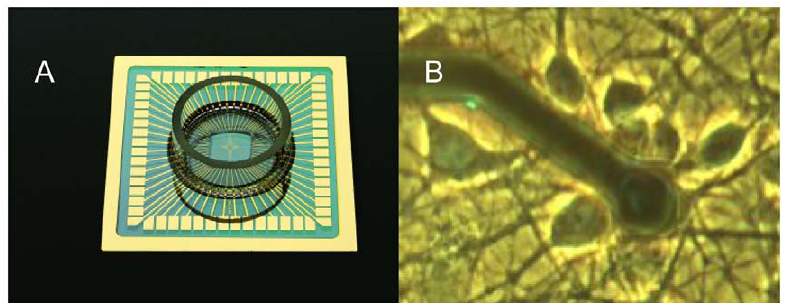
Figure 1. Multi electrode array (MEA) and close up of one of the electrodes. A : MEA, used to record neuronal activity in cultured networks of cortical neurons. It is based on a glass substrate with 60 embedded electrodes in the centre of the chamber, with 100 m m inter electrode distance. The glass ring glued on top was filled with glia conditioned growth medium and firmly sealed. B : close up of one of the electrodes and several neurons. Electrode diameter: 10 m m. Most electrodes did not pick up signals from more than one neuron.